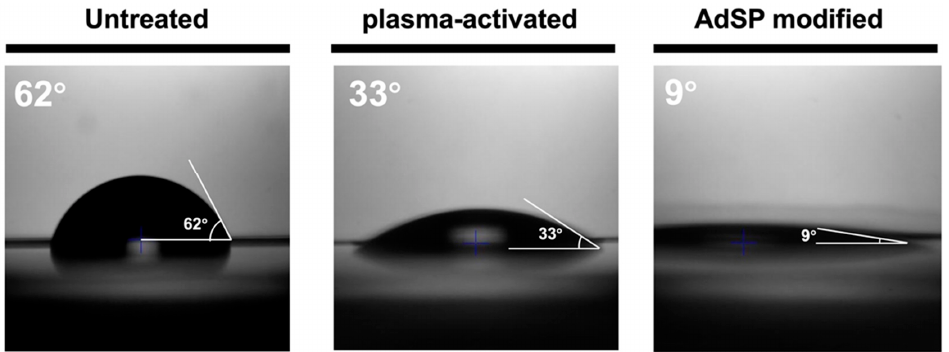
Figure 6. The average contact angle values for the untreated non-adhesive dish, the plasma-acti- vated dish, and the AdSP-modified dish.